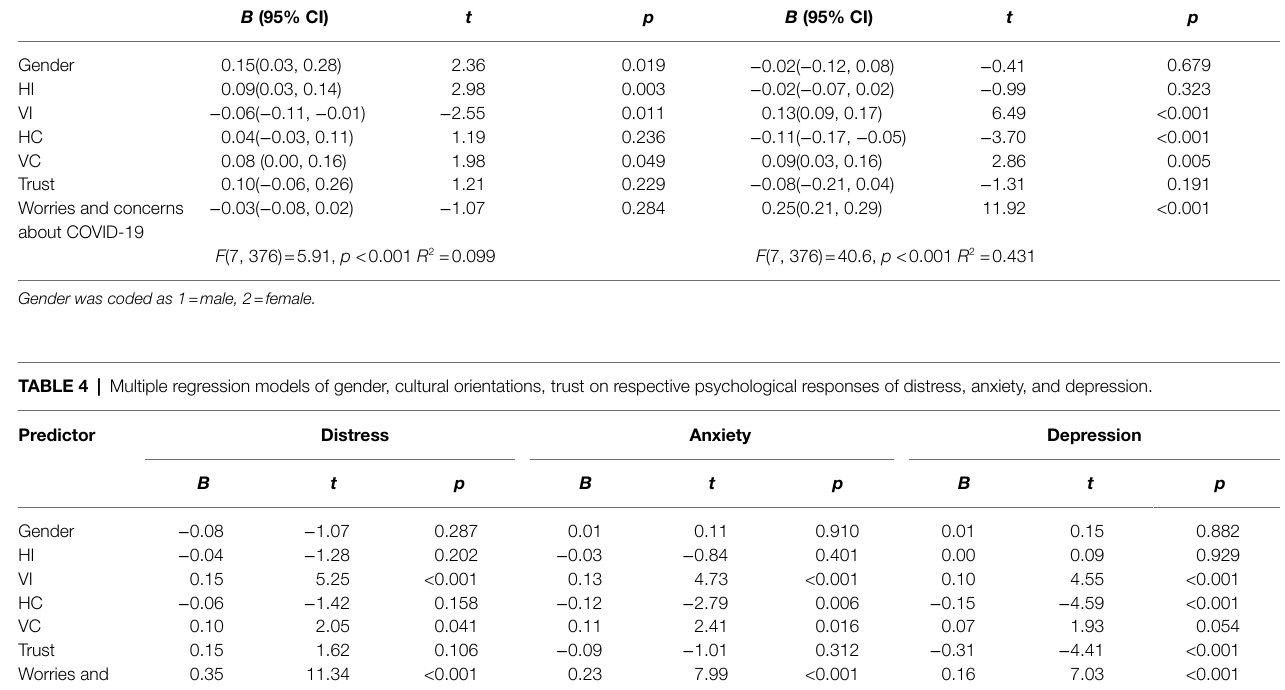
TABLE 3 | Multiple regression models of gender, cultural orientations, trust on attitudes toward compliance, and negative psychological responses. Predictor